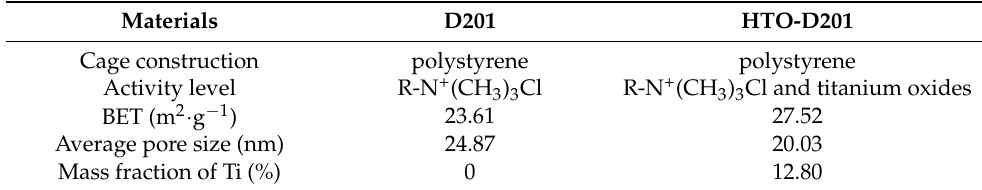
Table 1. Comparison of basic properties of D201 and HTO-D201.